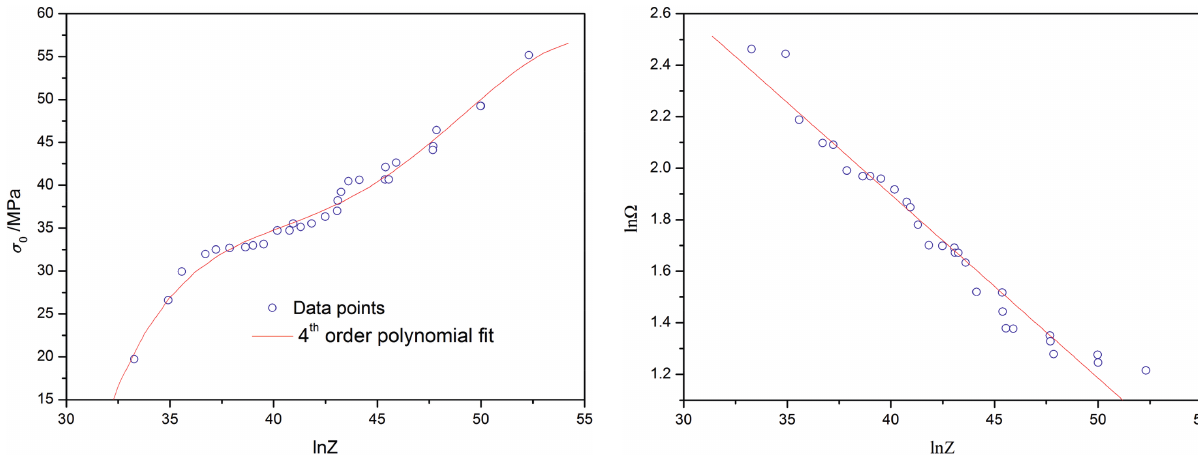
Figure 9: Relationship between Ω and the Zener – Hollomon